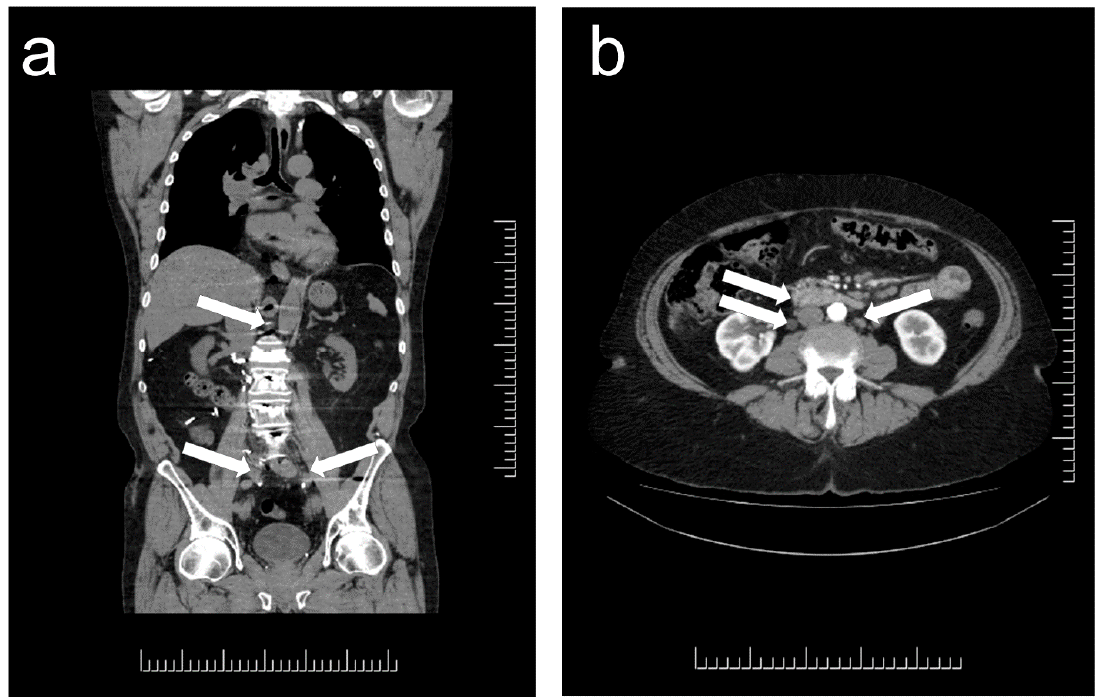
Figure 2. Localization of paragangliomas on Computed Tomography (CT) imaging. Multifocal paraganglia in patients with genetic predisposition to paraganglioma syndrome. ( a ) There are multiple small lesions all along the para-aortic channel (arrows), each representing a small paraganglioma in this patient with germline predisposition and multiple tumors, including multiple liver lesions. ( b ) In this patient with genetic predisposition to paraganglioma, there are multiple masses (arrows) that the radiology report identified as “multiple mesenteric lymph nodes, the largest one measures 5.1 × 1.9 cm, and there also sub-centimetric retroperitoneal lymph nodes”.